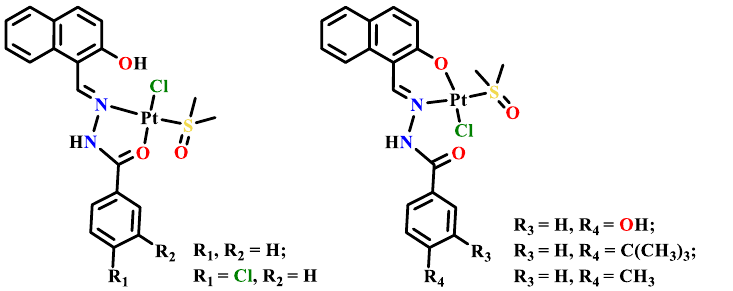
Figure 31. A series of Pt(II) complexes of naphthylhydrazone with different benzamide derivatives as side chains. as side chains.